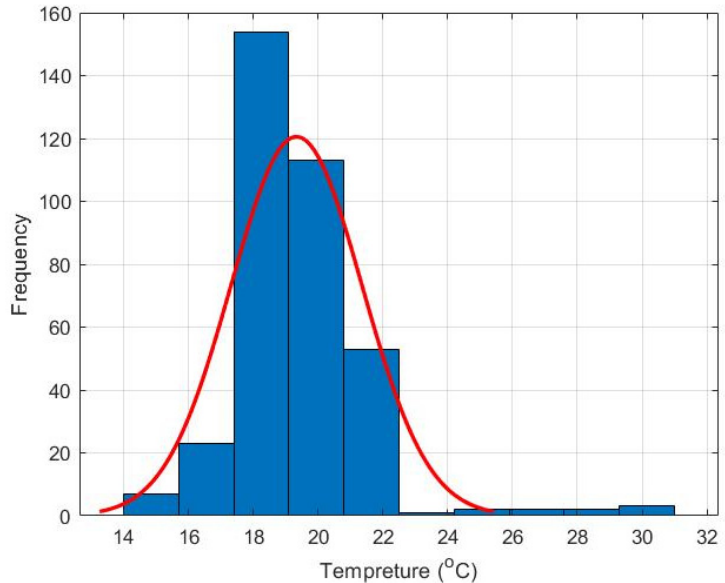
Figure 20. Histogram for the SHC temperature variation.